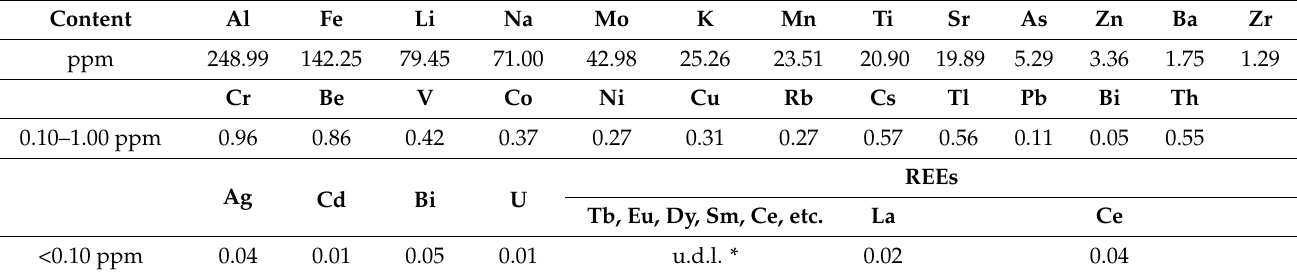
Table 1. Trace element concentrations of La Sassa quartz obtained by ICP-MS.